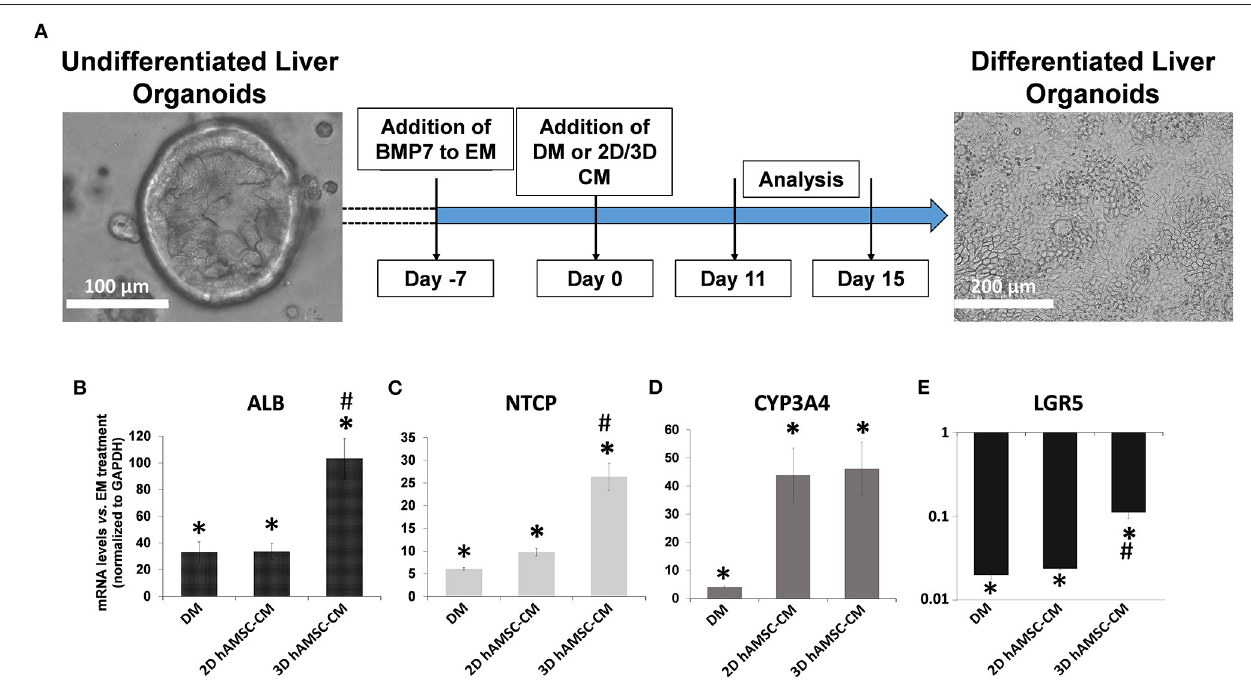
FIGURE 3 | Differentiation of organoids. (A) Experimental design (with DIC images of undifferentiated and differentiated liver organoids) to study the potential effects of MSC-derived conditioned medium (CM). (B–E) Expression analysis of markers of hepatic differentiation ( ALB , NTCP , and CYP3A4 ) and of the stem marker ( LGR5 ) in liver organoids differentiated for 15 days in each condition. DM, differentiation medium; EM, expansion medium; 2D hAMSC-CM, DM conditioned for 3 days by hAMSCs grown in monolayer; 3D hAMSC-CM, DM conditioned for 3 days by hAMSCs grown as spheroids. Transcript levels were normalized to those of GAPDH and expressed as fold change (2 − 11 Ct ) vs. EM. Data are means ± SD.; * p < 0.05 vs. EM; # p < 0.05 vs. 2D hAMSC-CM. DIC, differential interference contrast.